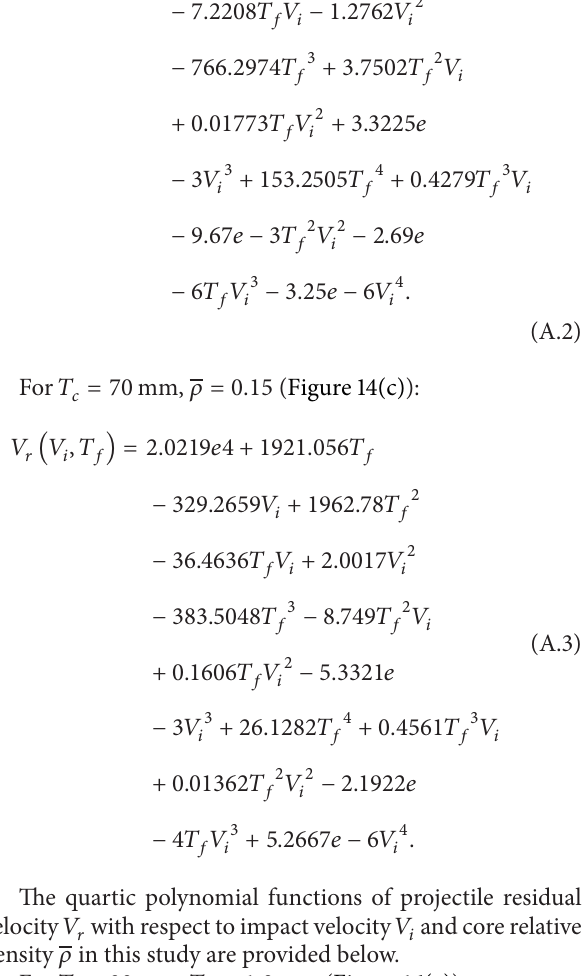
(5) Quartic polynomial functions can properly approxi-